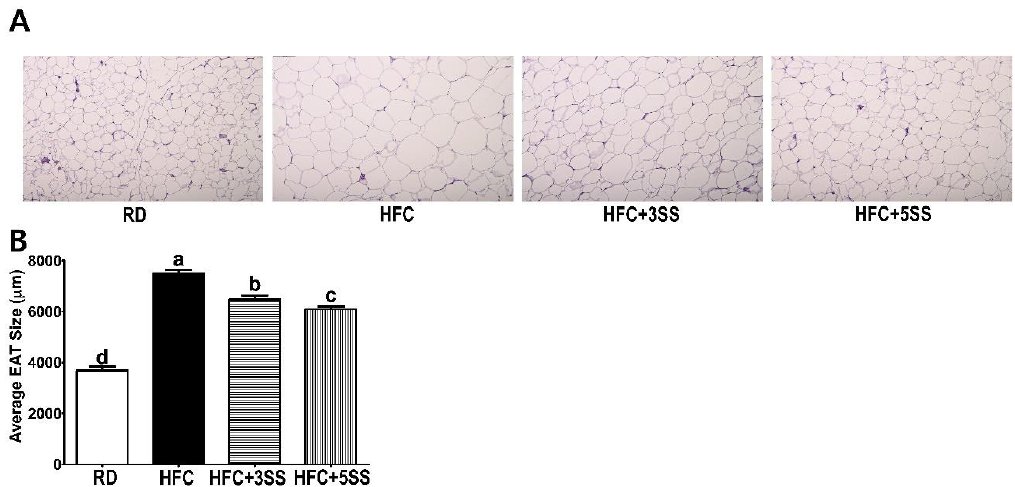
Figure 7. Effect of S. sieboldii Miq. root powder (SS) on adipocyte size. Experimental rats were fed a regular diet (RD) or a high-fat and high-cholesterol (HFC) diet with or without Stachys sieboldii Miq. root powder (SS; 3 or 5%) supplementation for 6 weeks. The epididymal adipose tissue (EAT) was stained with Hematoxylin and Eosin (HE). Magnification, 100×. The EAT surface area was quantified using the Image J program. ( A ) Representative EAT images; ( B ) Quantification of the surface area of EAT. RD, regular diet; HFC, high-fat and high-cholesterol diet; HFC + 3SS, High-fat and high- cholesterol diet + 3% of Stachys sieboldii Miq. root powder; HFC + 5SS, high-fat and high-cholesterol diet + 5% of Stachys sieboldii Miq. root powder. Values are means ± standard deviation, n = 8. Data were analyzed using one-way ANOVA followed by Tukey’s post hoc test. Means labeled without a common letter differ significantly, p < 0.05.